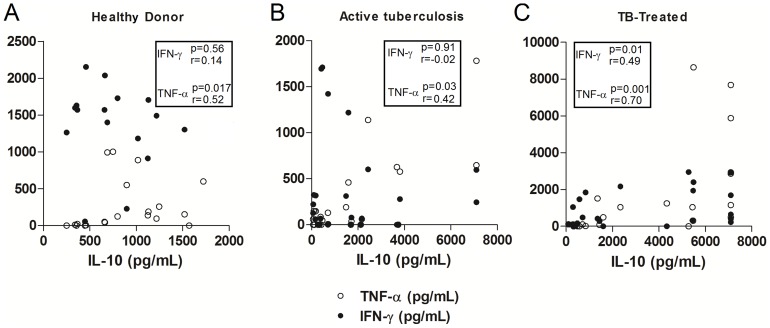
Correlation between IL-10 and Th1 cytokines in active and clinical cured tuberculosis.Correlation between IL-10 and IFN-γ or TNF-α levels produced by PBMCs from Healthy Donors (A), patients with active tuberculosis (B) and clinically cured patients (C) in stimulated cultures (4 µg/mL M. bovis antigen). Values of p and r determined using Spearman's correlation test.